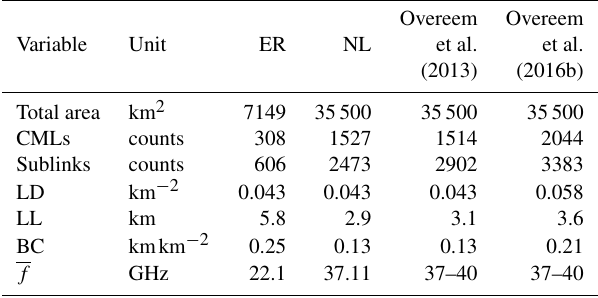
Table 1. CML dataset comparison.